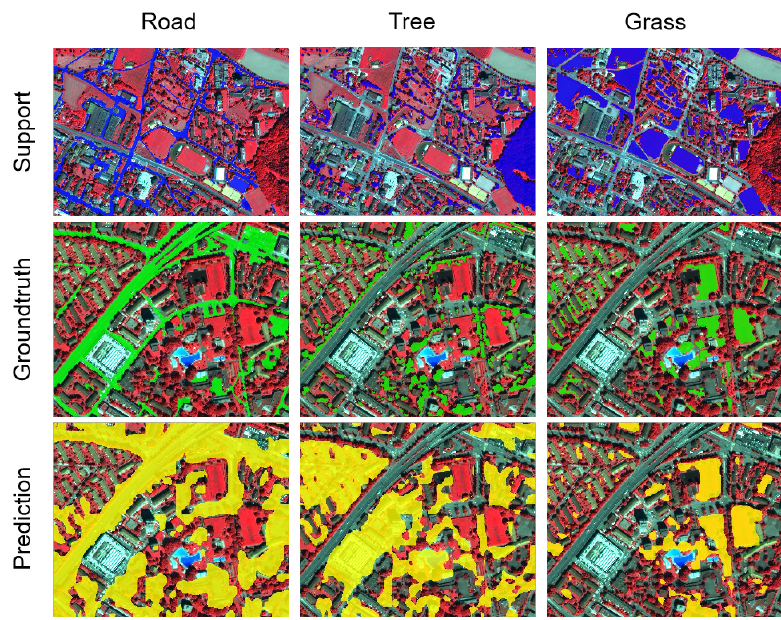
Figure 9. Rough segmentation results on